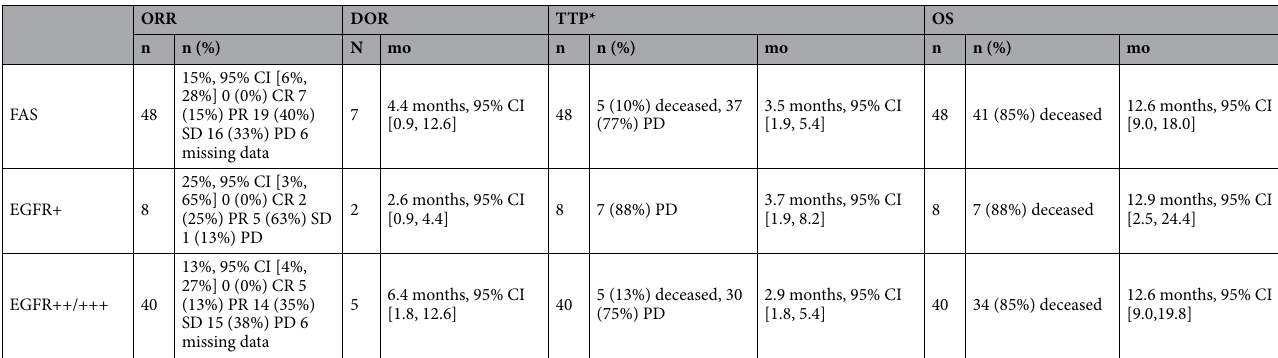
Table 2. Secondary endpoints. ORR, overall response rate. CR, complete response. PR, partial response. SD, stable disease. PD, progressive disease. DOR, duration of response. TTP, time to progression. OS, overall survival. FAS, full analysis set. *Equivalent to PFS as all deaths were considered as cancer-related. °41 patients have died at time of the current analysis.